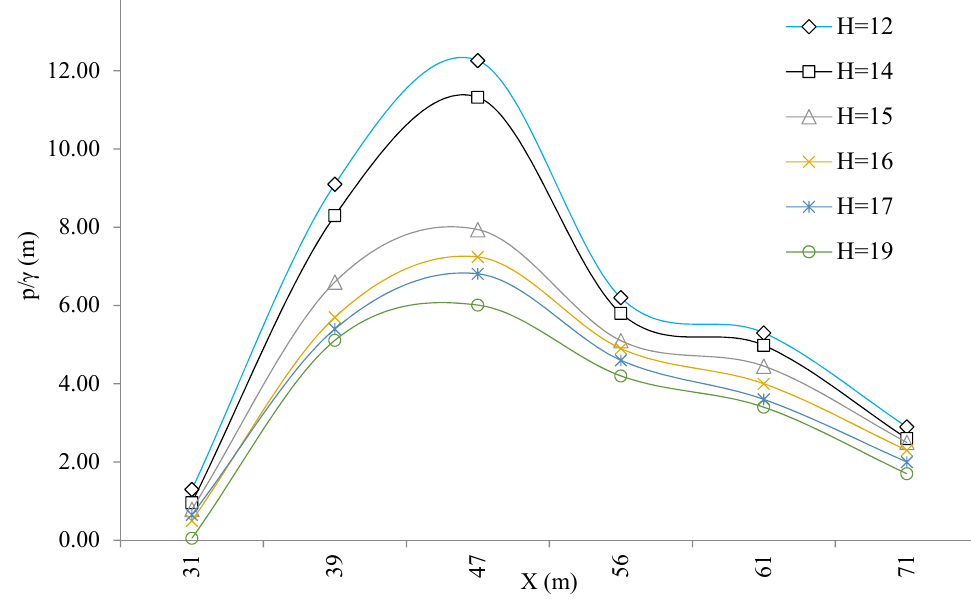
Figure 8. Spillway chute pressure distribution for M 3 .